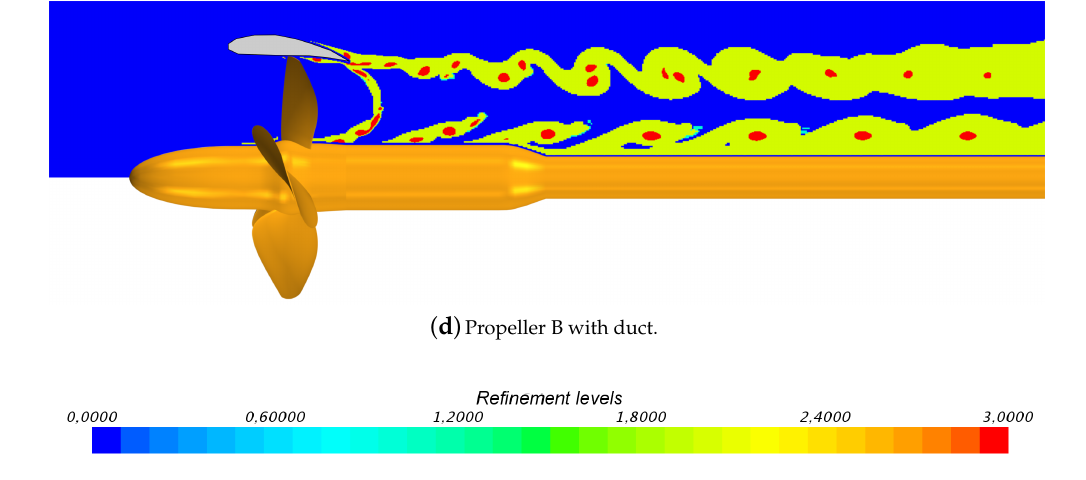
Figure 10. Longitudinal section of the obtained refinement levels.